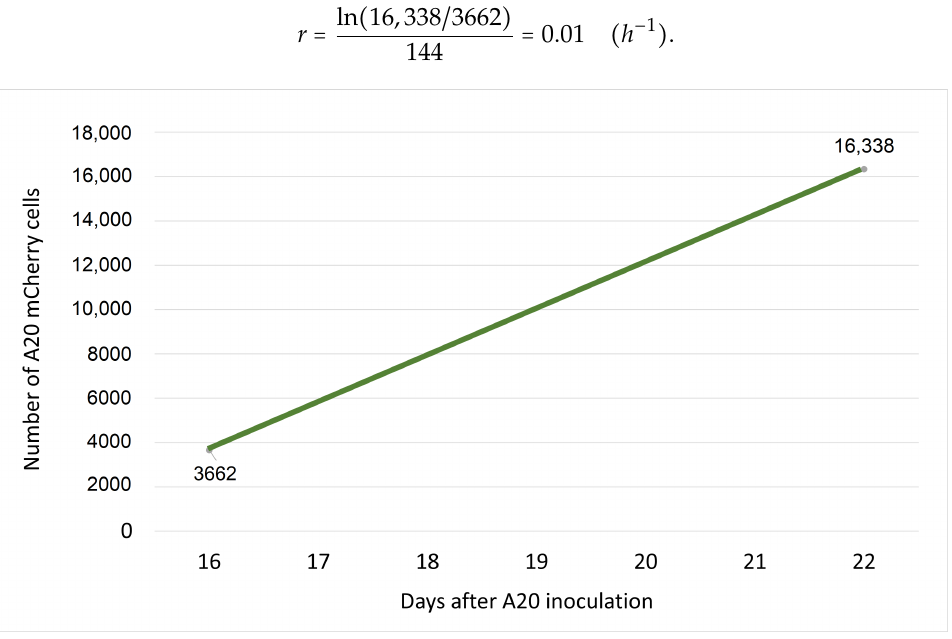
Figure 2. Growth of A20 cells in vivo. Twenty Balb/c mice were inoculated via the tail vein with 5 × 10 4 A20 cells. On Day 16, blood was collected from the tail vein of four randomly chosen mice, and again on Day 22 from four other mice. A20 mCherry positive cells were measured on a CytoFLEX (Beckman Coulter) flow cytometer. Acquired data were analyzed using FlowJo software. The points on the graph represent the average number of A20 mCherry cells measured among 2 × 10 5 blood cells analyzed from 4 mice. These data were used to calculate the growth rate of the cells in vivo.